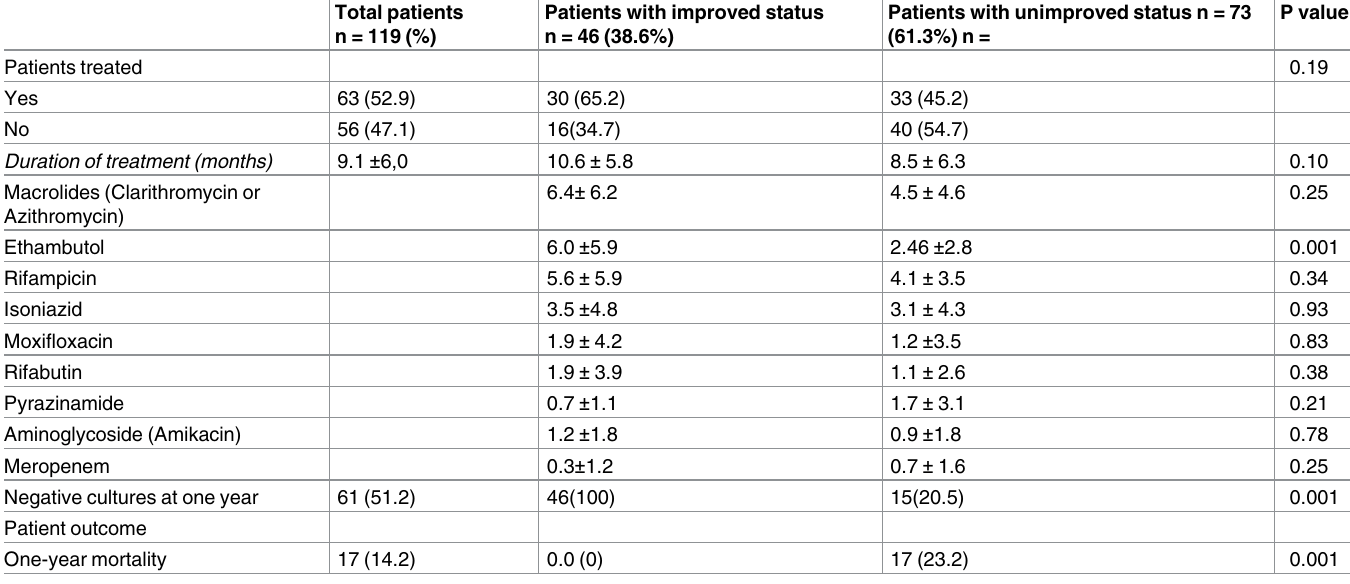
Table 4. Therapeutic characteristics of the patients.